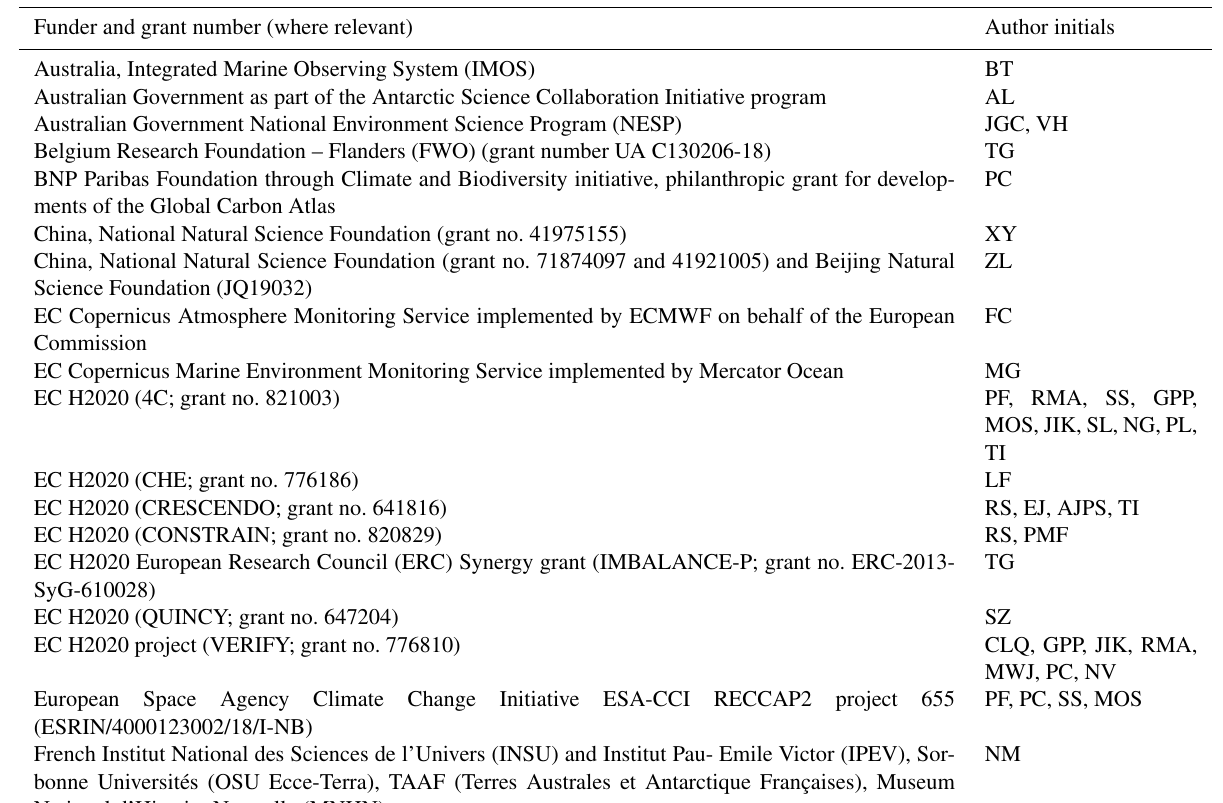
Table A9. Funding supporting the production of the various components of the global carbon budget in addition to the authors’ supporting institutions (see also